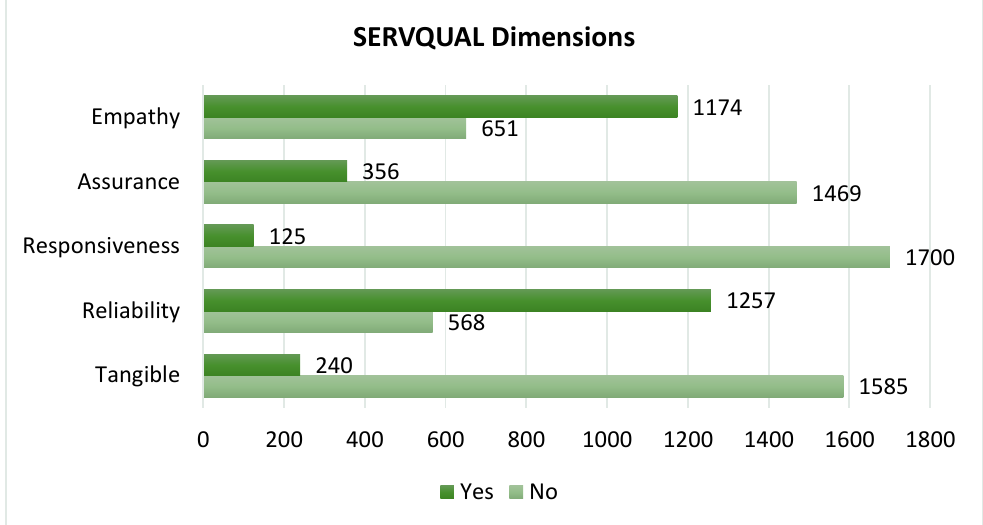
Figure 3. Overall SERVQUAL dimensions classified by machine learning.